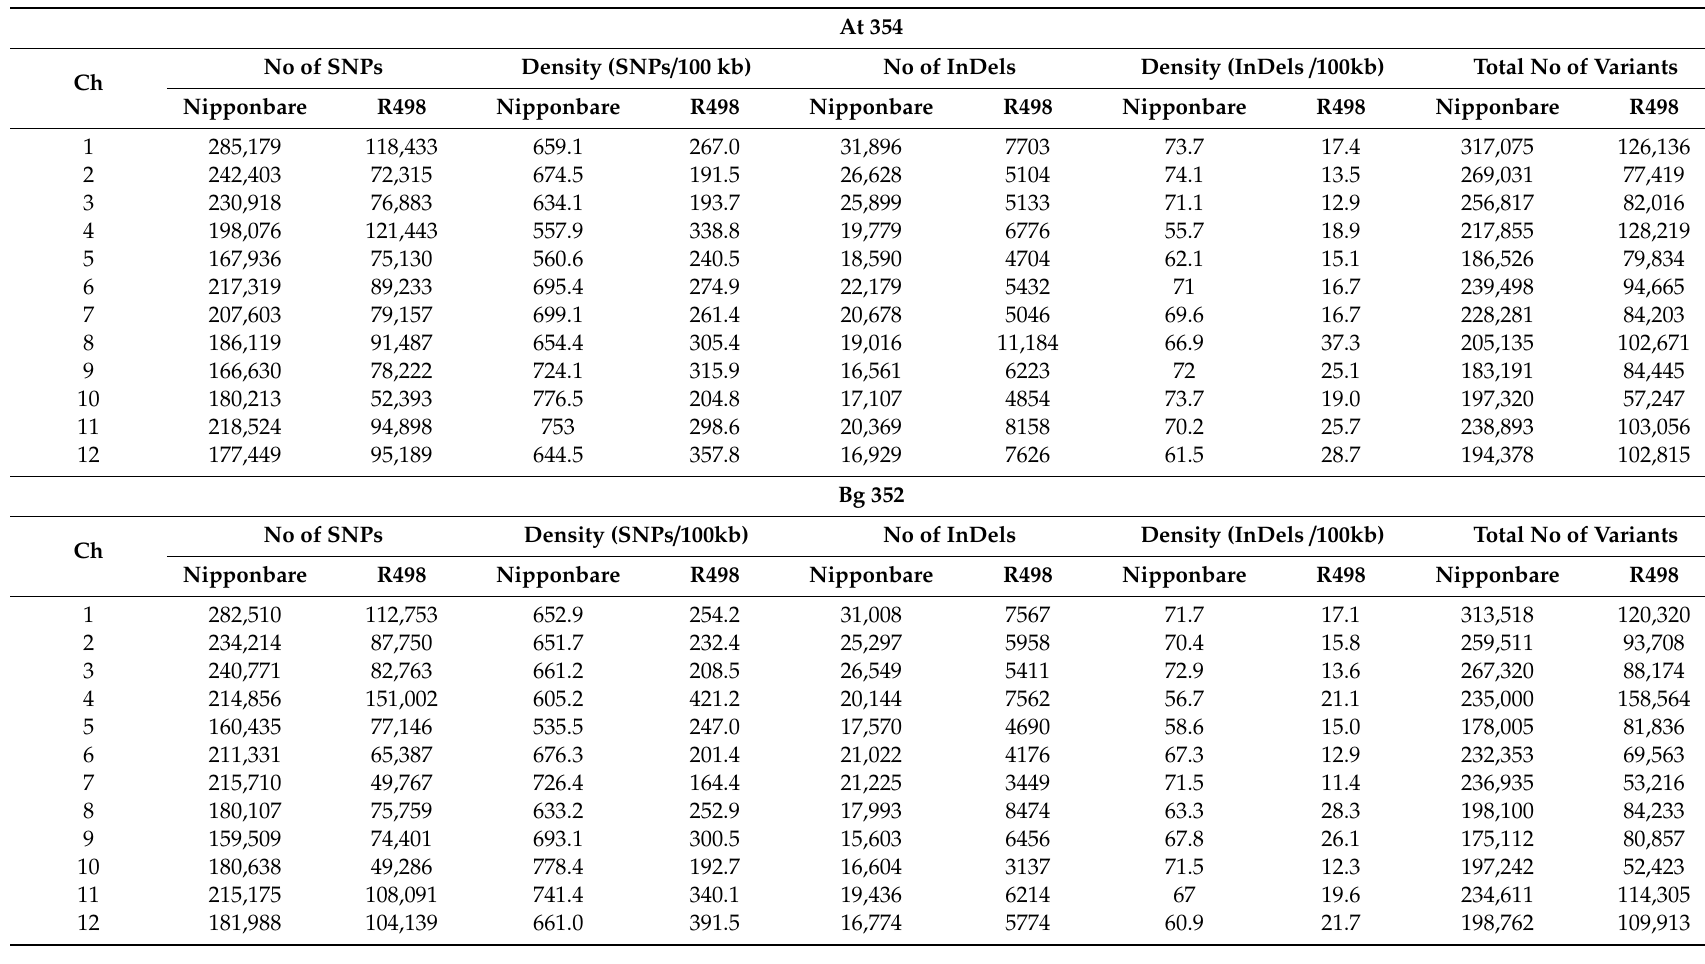
Table 2. Occurrence and density of SNPs and InDels within the 12 chromosomes in At 354 and Bg 352 genomes after quality